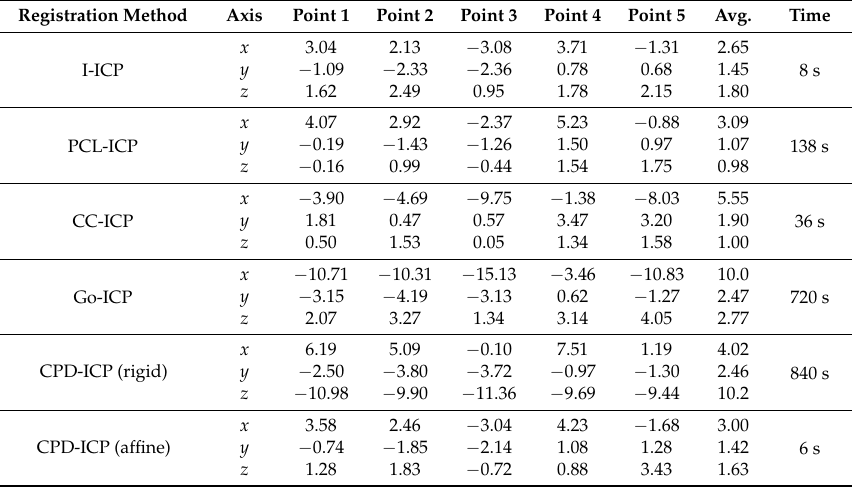
Table 4. Results of alignment errors